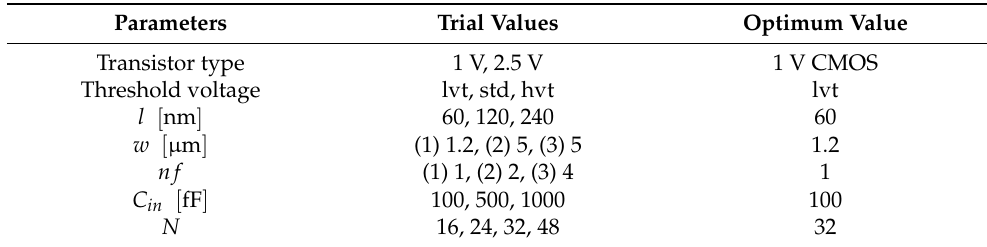
Table 2. Optimum circuit parameters.